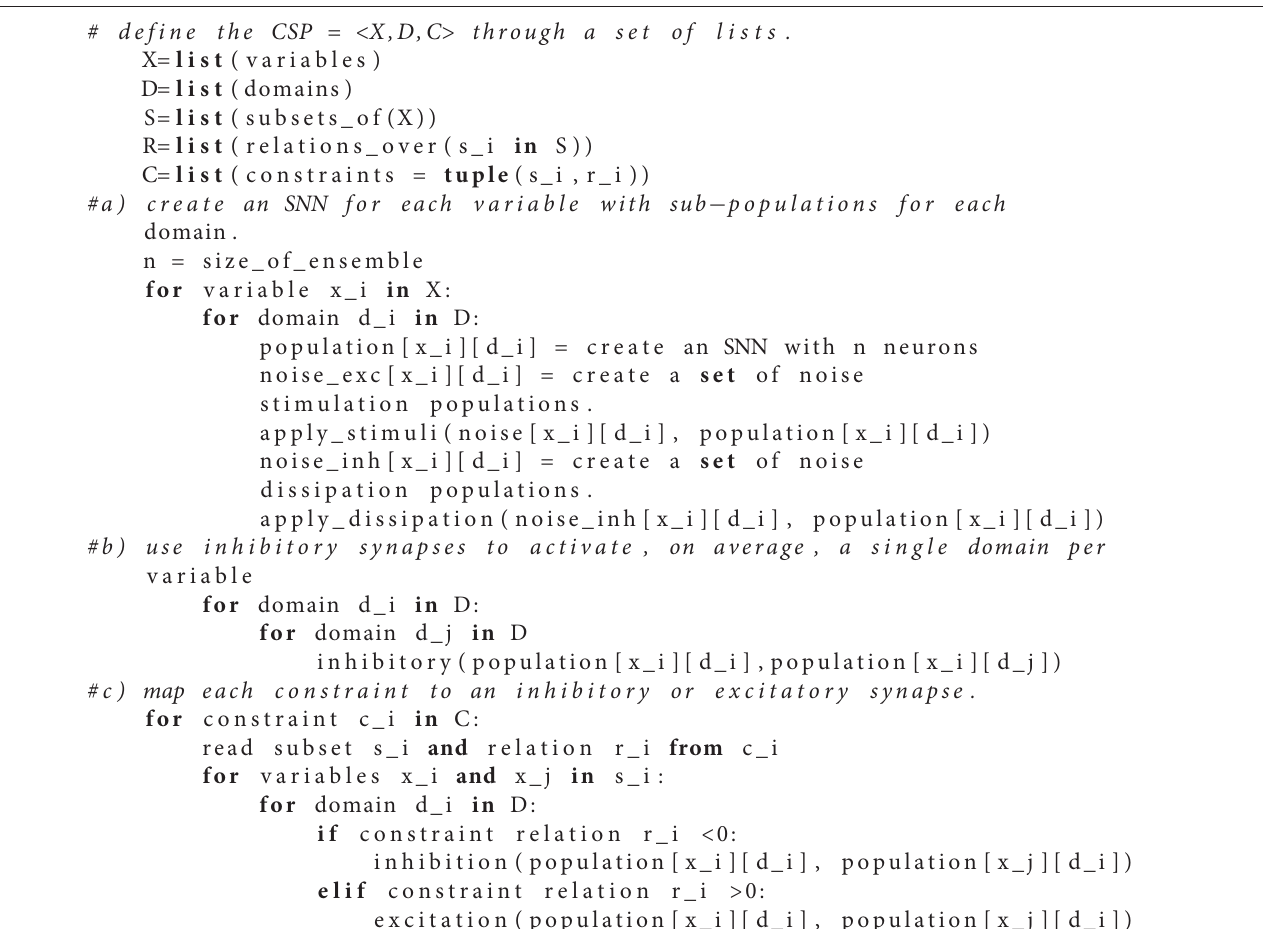
Algorithm 1 | Translation of a CSP into an